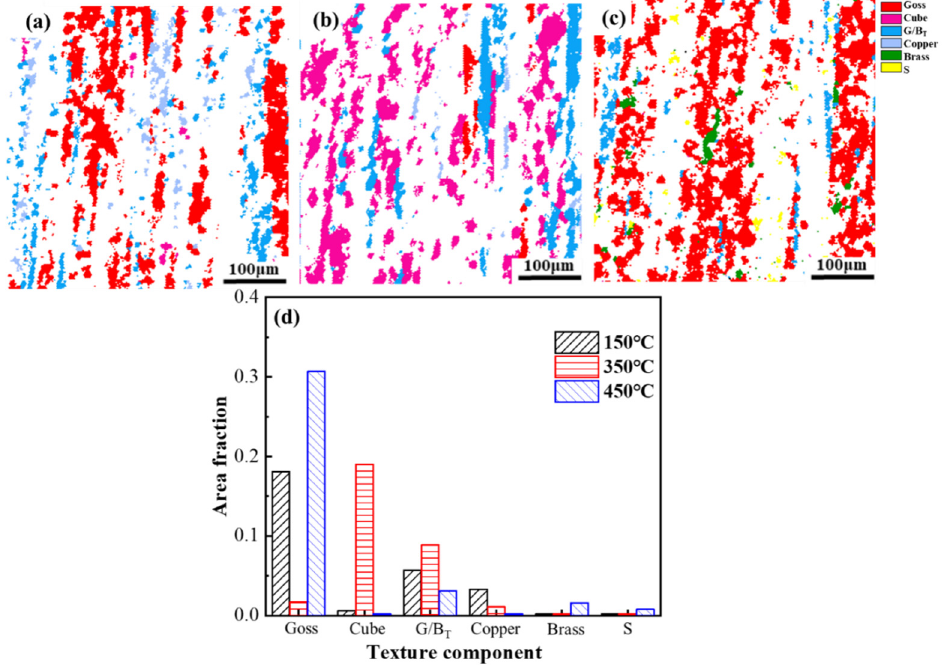
Figure 10. The maps of the main texture in the specimens annealed at ( a ) 150 °C, ( b ) 350 °C and ( c ) 400 °C after thermal cycling. ( d ) Area fraction of main texture components after thermal cycling (N = 12).